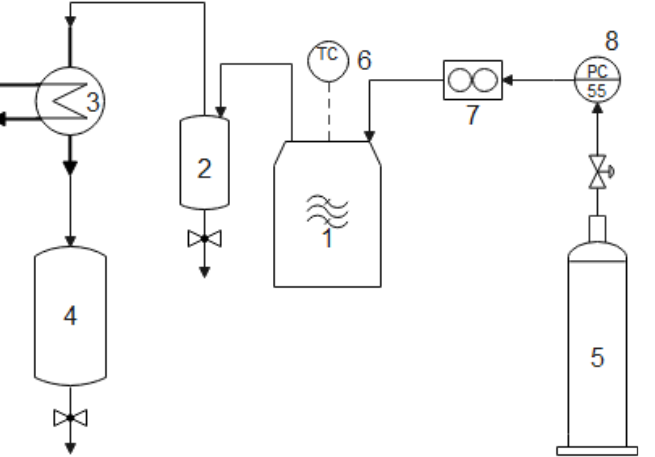
Figure 1. Concept scheme of the microwave heated laboratory equipment of 3.3 kW/2450 MHz: 1 — microwave reactor, 3.3 kW, 2.45 GHz; 2 — hot gas expansion vessel; 3 — condenser; 4 — liquid phase collector vessel; 5 — inert gas tank; 6 — temperature controller; 7 — gas flow meter; 8 — pressure controller.